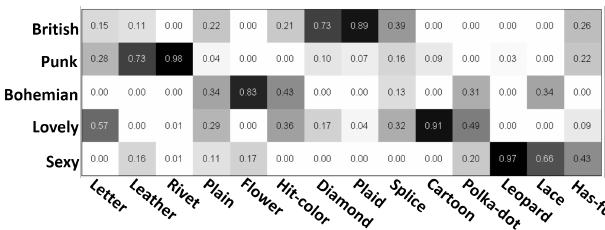
Figure 5: The correlation matrix between styles and fashion